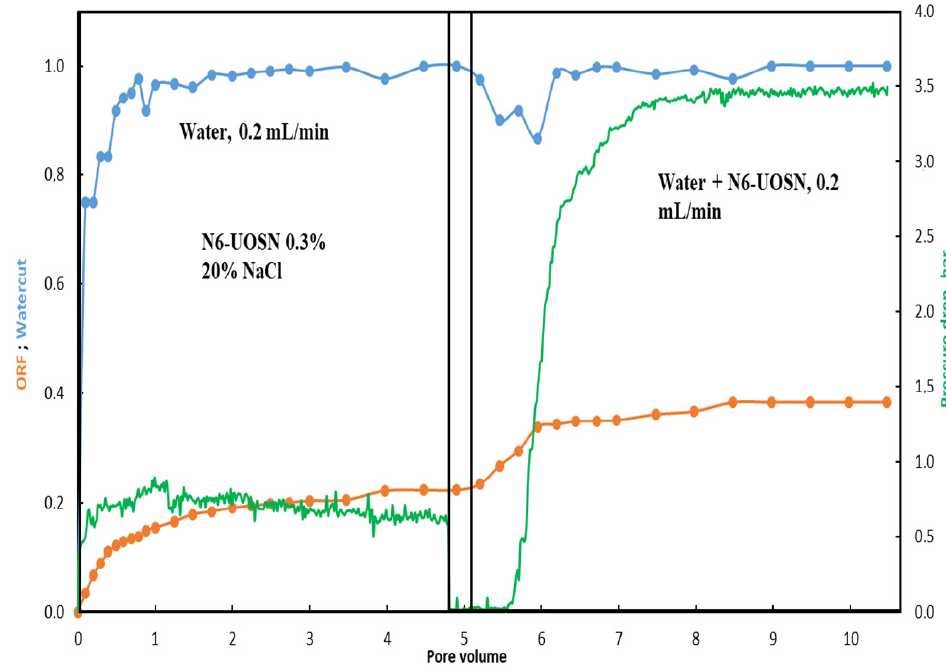
Figure 9. Oil displacement experiment of NP6EO–UOSN flooding.